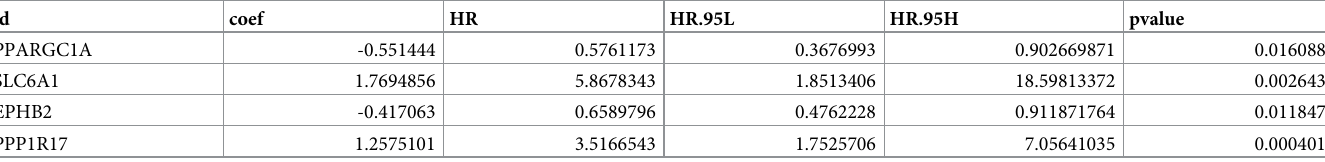
Table 3. Four gene signature selected by multivariate Cox